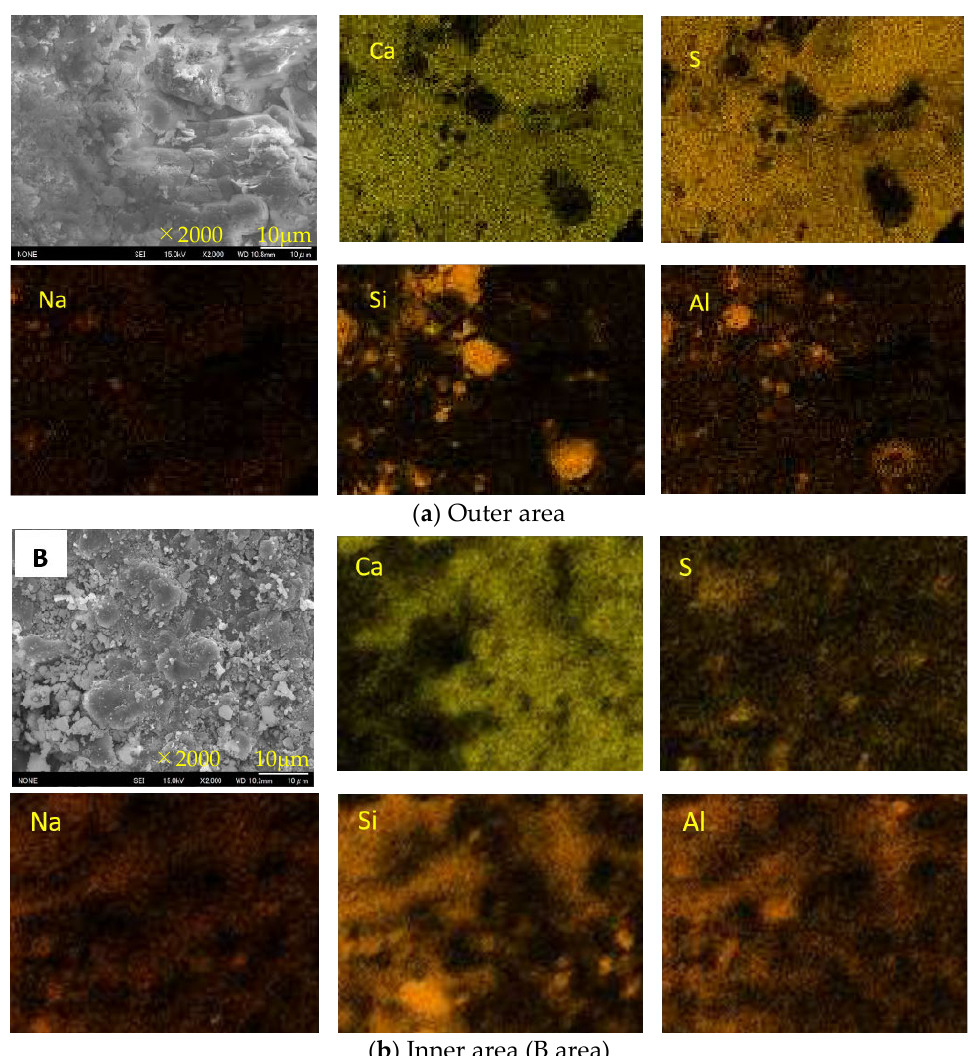
Figure 15. SEM images and element maps of the AS21 - 45 specimen.